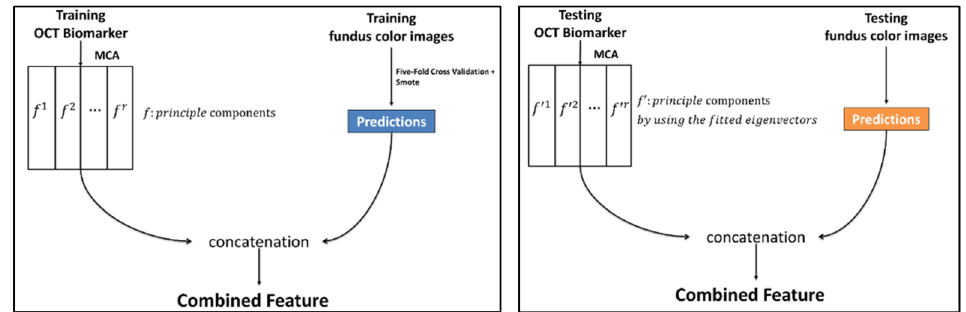
Figure 6. Feature engineering. This figure revealed the process of feature engineering in OCT biomarkers and CFPs with training (left) and testing (right) datasets.